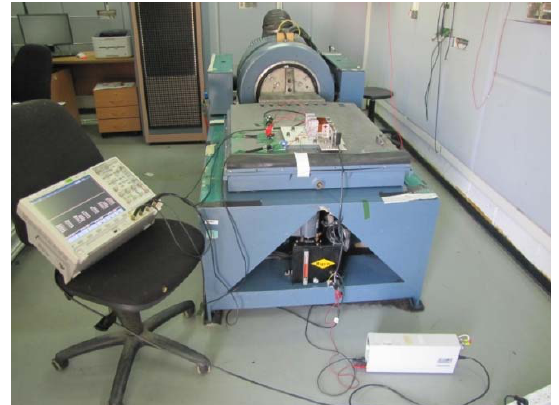
Figure 5. The experimental setup.